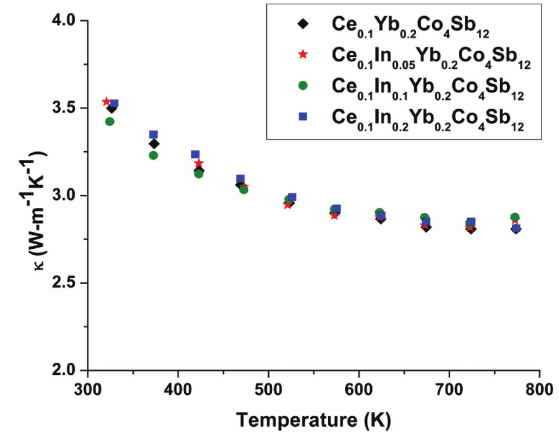
Figure 8. Temperature dependent thermal conductivity of the Ce 0.1 In y Yb 0.2 Co 4 Sb 12 skutterudites.